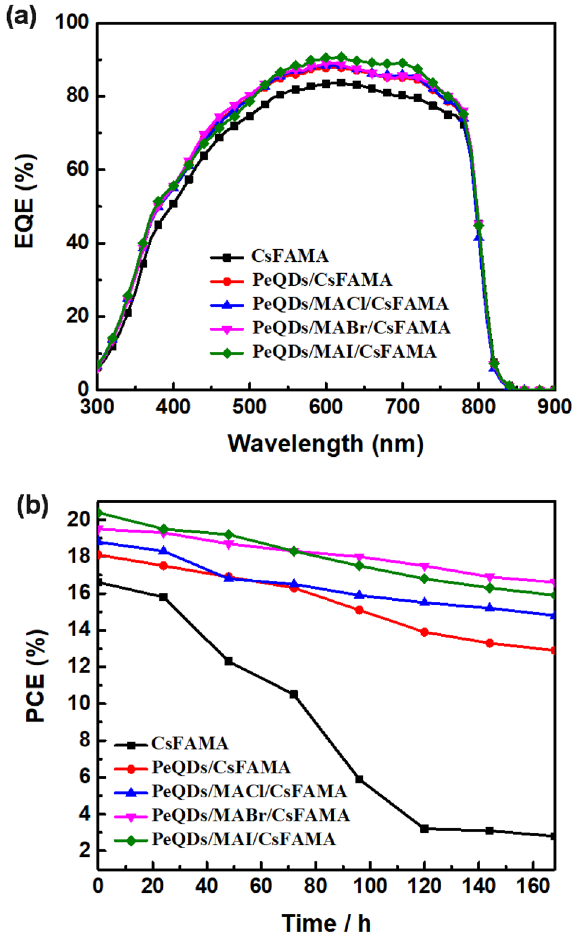
Figure 8. ( a ) External quantum efficiency (EQE) spectra and ( b ) normalized PCE stability evolution (N 2 -filled glovebox) of the PeSCs based on the CsFAMA, PeQDs/CsFAMA, and PeQDs/MAX (Cl, Br,